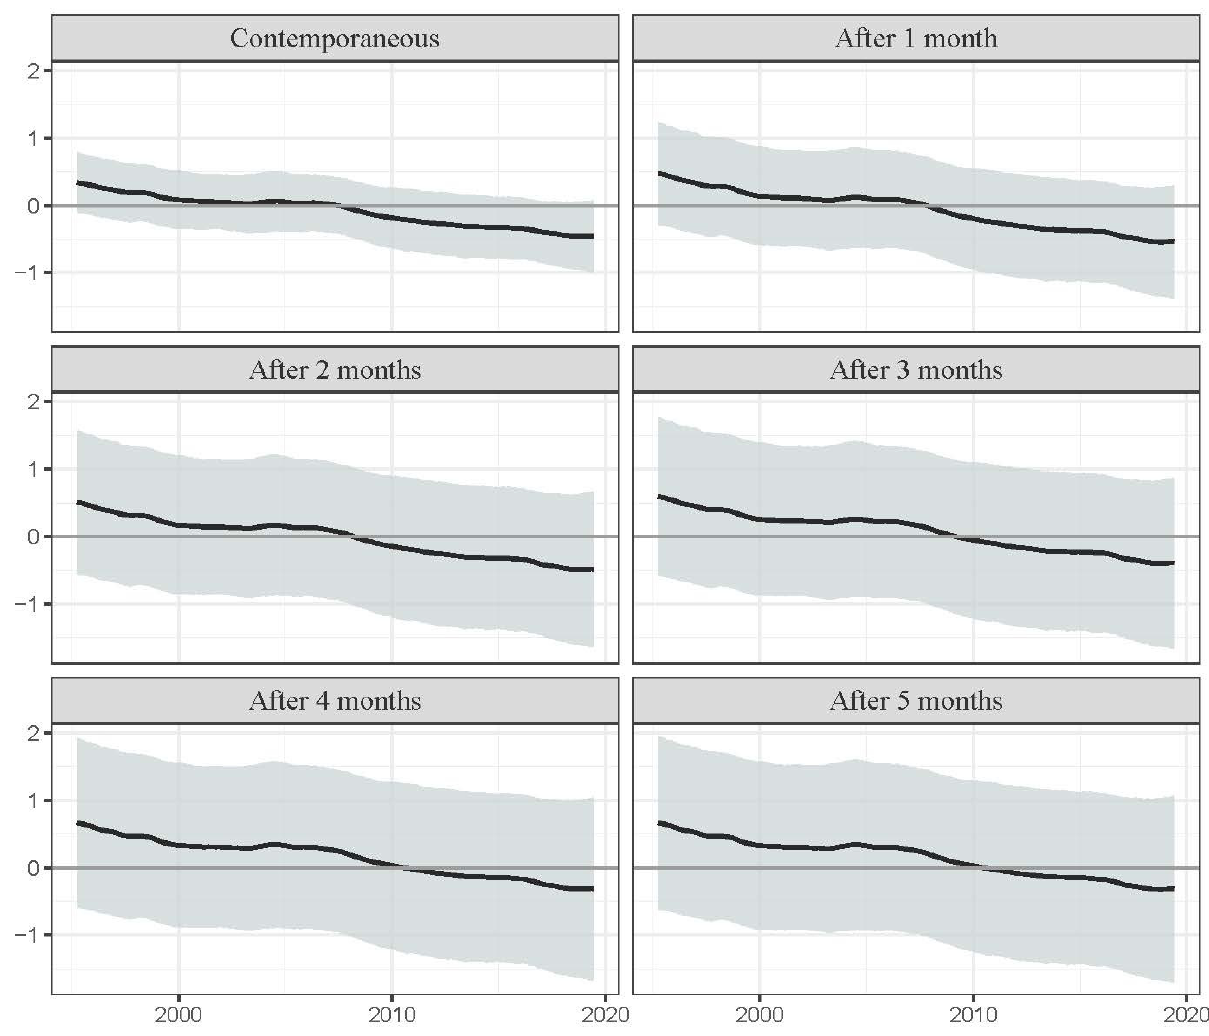
Figure 4. Responses of stock returns to an oil supply shock. Note: This figure presents the accu- mulated responses of stock returns to a one-unit oil supply shock in the first five months after the shock (1995:04–2019:06). The solid black line shows the mean while the gray area displays the 16th and 84th percentiles.